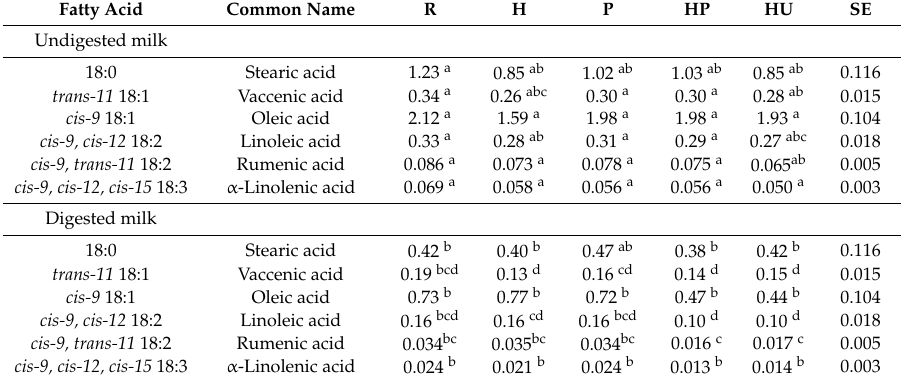
Table 2. Ratios of 18-carbon fatty acids to myristic acid (14:0) for differently processed milk before and after a 3 h gastro-intestinal